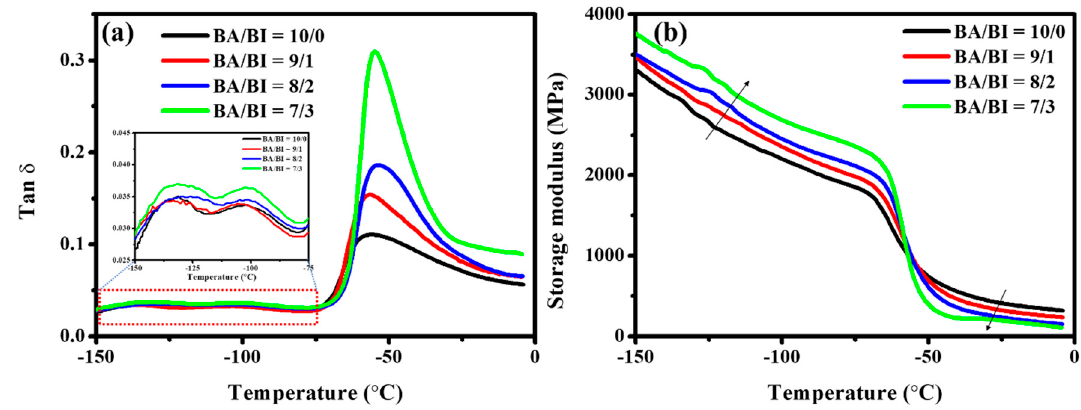
Figure 5. ( a )Tan δ and( b )storagemodulusofthePBABIcopolyesters, Figure 5. ( a ) Tan δ and ( b ) storage modulus of the PBABI copolyesters, via the dynamic mechanical analyzer.